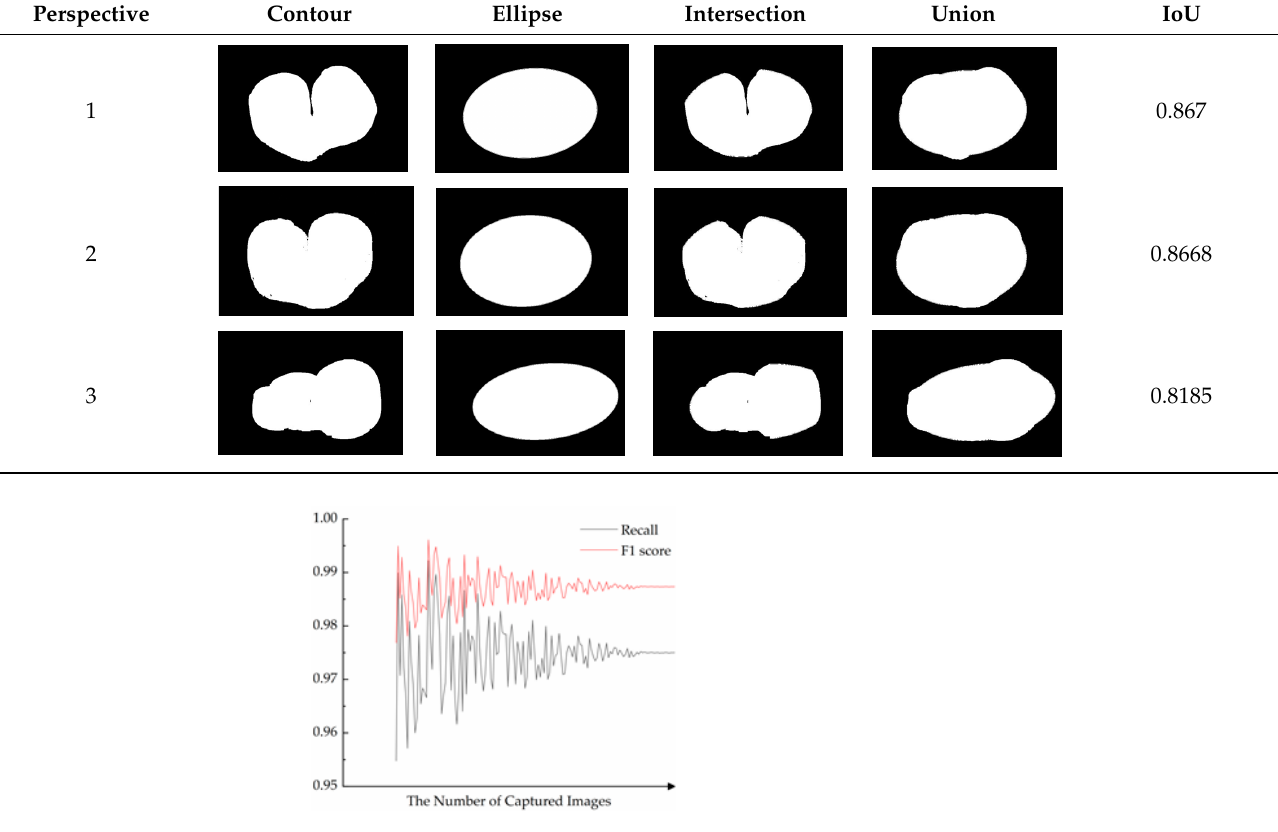
Figure 16. The influence of shooting perspective on algorithm robustness.